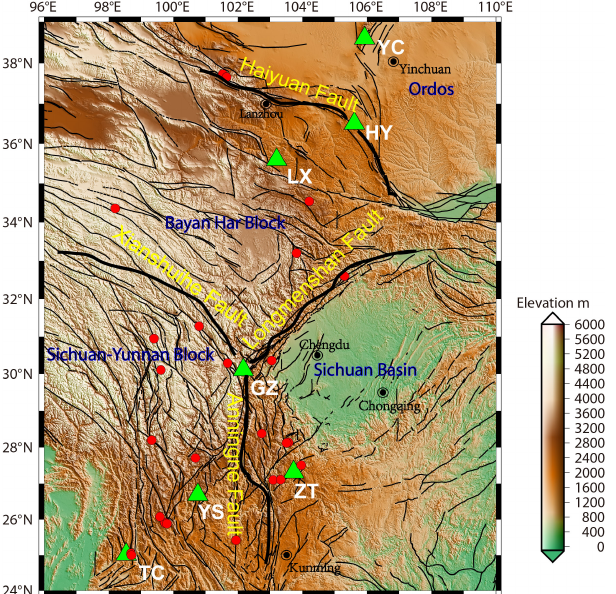
Figure 1. Map showing the tectonic settings of the Western China and the locations of seven borehole strain staioins (green triangles). The thin Black curves indicate faults. The bold black curves indicate the main faults. The red circles show the epicenters of 26 earthquakes ( E s ≥ 10 7 ) in the study